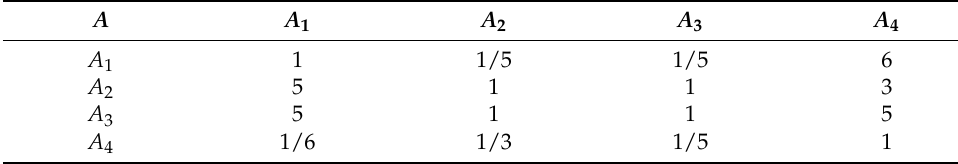
Table 7. Judgment matrix of hydrological condition indicators.